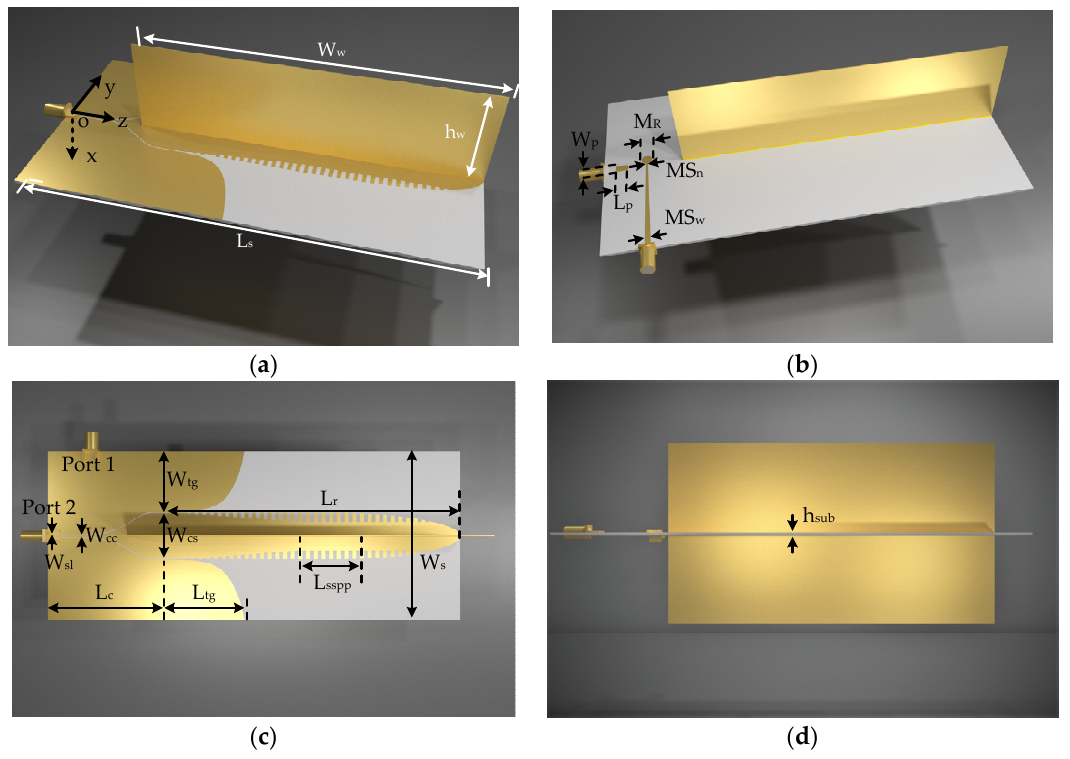
Figure 1. Antenna configuration. ( a ) Top side view; ( b ) back side view; ( c ) top view; ( d ) side view.